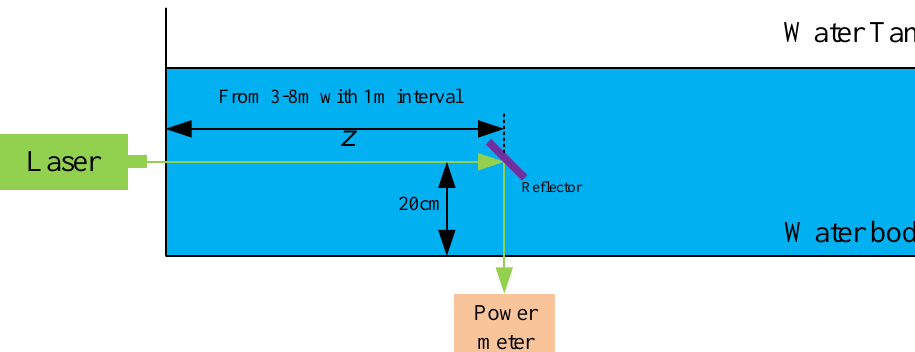
Figure 3. Schematic diagram of Beer–Lambert law experiment.